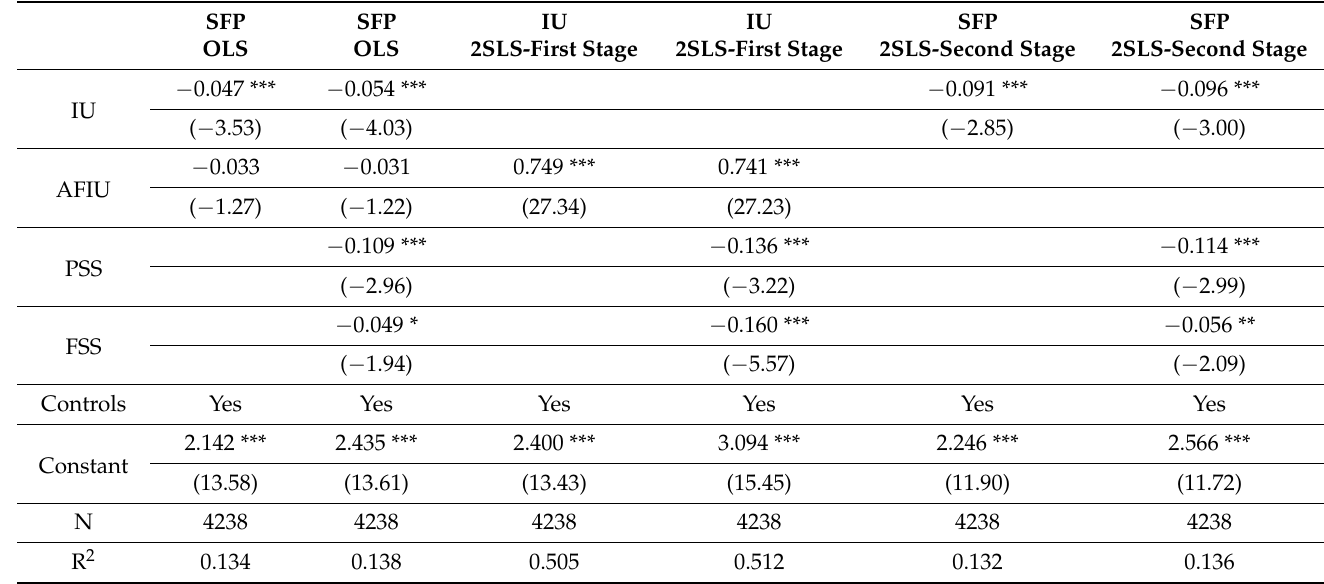
Table 3. Tests for the validity of the instrument and the 2SLS